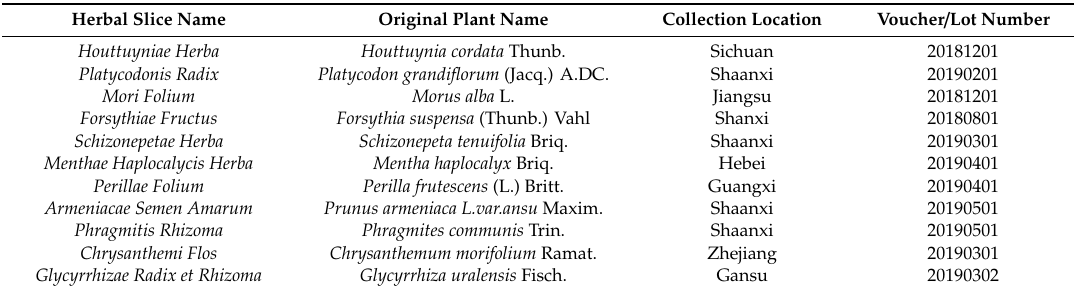
Figure 5. Chemical structures of seven determined compounds. Table 13. Information on the of herbal slices used in the negative sample preparation.